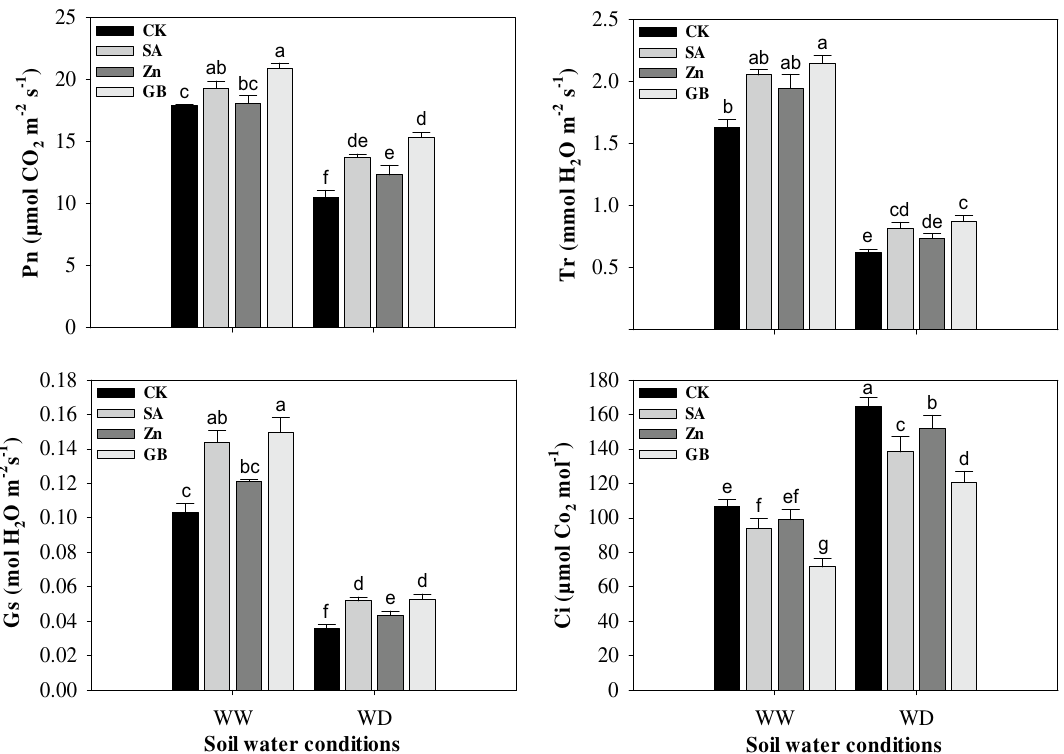
Figure 2. Effect of soil water conditions and foliar treatments on net photosynthesis rate (Pn), transpiration rate (Tr), stomatal conductance (Gs), and intercellular CO 2 concentration (Ci). Every column in each graph represents the mean (± SE) of three replicates. Different letters above columns indicate that means are different at 95% confidence level. WW, well-watered; WD, water-deficient; CK, control (double distilled water); SA, salicylic acid; Zn, Zinc; GB, Glycine